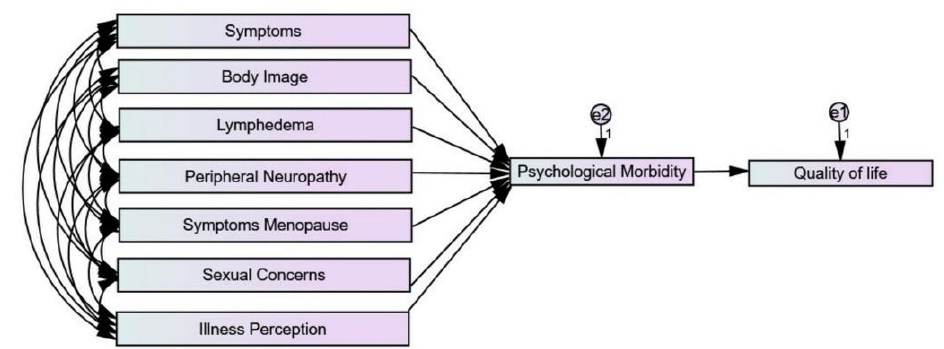
Figure 1. Initial model tested.